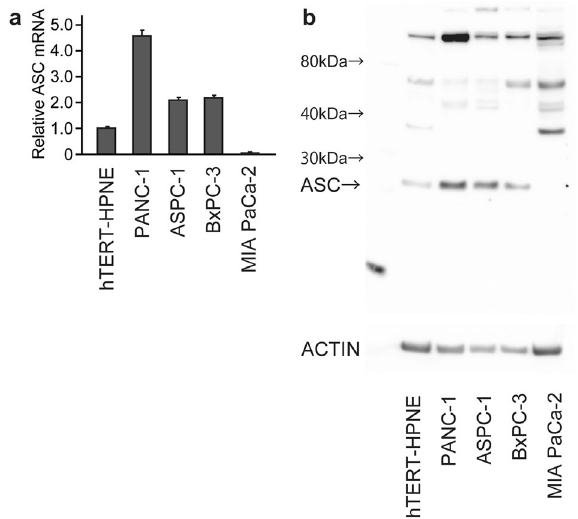
Figure 3. ASC expression in human PDAC cells. Four human PDAC cell lines and one human pancreatic duct cell line were used to screen levels of ASC mRNA and protein expression using quantitative real-time RT-PCR and western blot. ( a ) ASC mRNA expression. Data represent the mean ± standard error of the mean of four replicates. ( b ) ASC protein expression. The original gel images of Western blotting are shown in Fig.